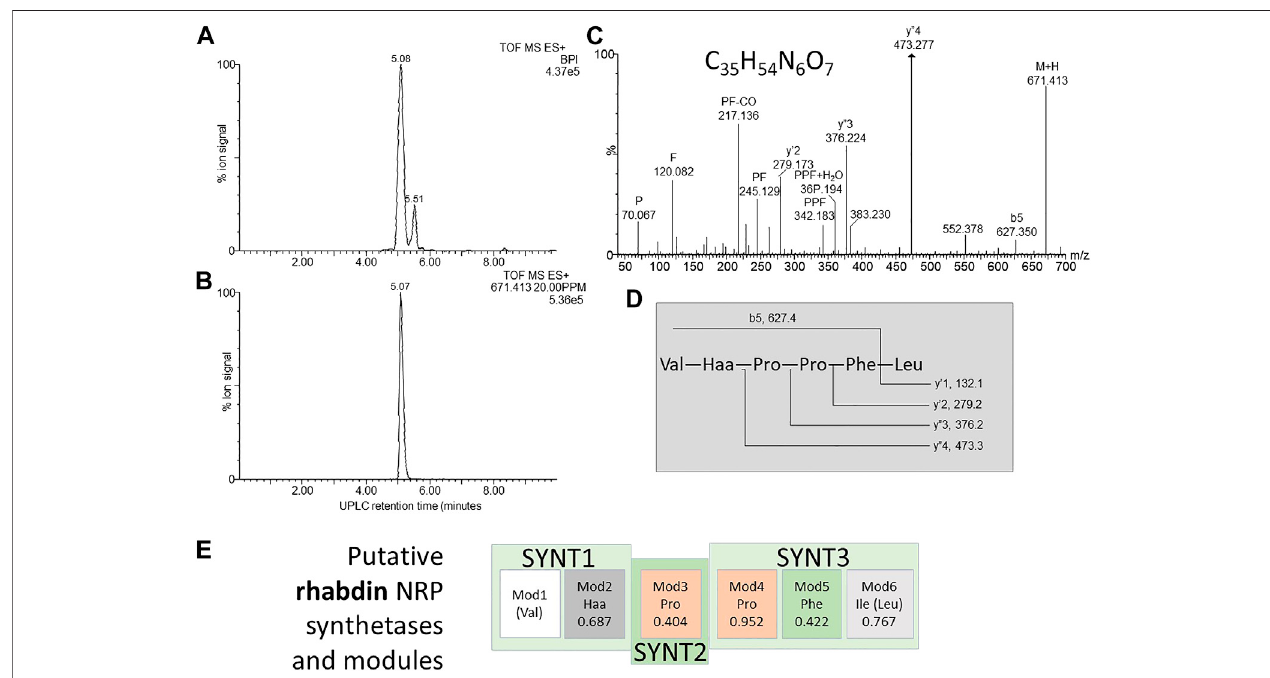
FIGURE 9 | Structural analyses of compound 17 – rhabdin. (A) UPLC-MS analysis of the puri fi ed compound and (B) the extracted m/z chromatogram of the rhabdin ion with m/z (cid:1) 671.413; (C) high resolution MS-MS spectrum of 671.413 annotated with putative ion identities; (D) proposed working structure for rhabdin; (E) putative NRPS operon for xenopep with the predicted amino acids for each module (Mod) in the synthetase (SYNT) and probability score (the greater the number the lower the probability). The amino acids found with amino acid analysis and MS-MS are given in brackets.